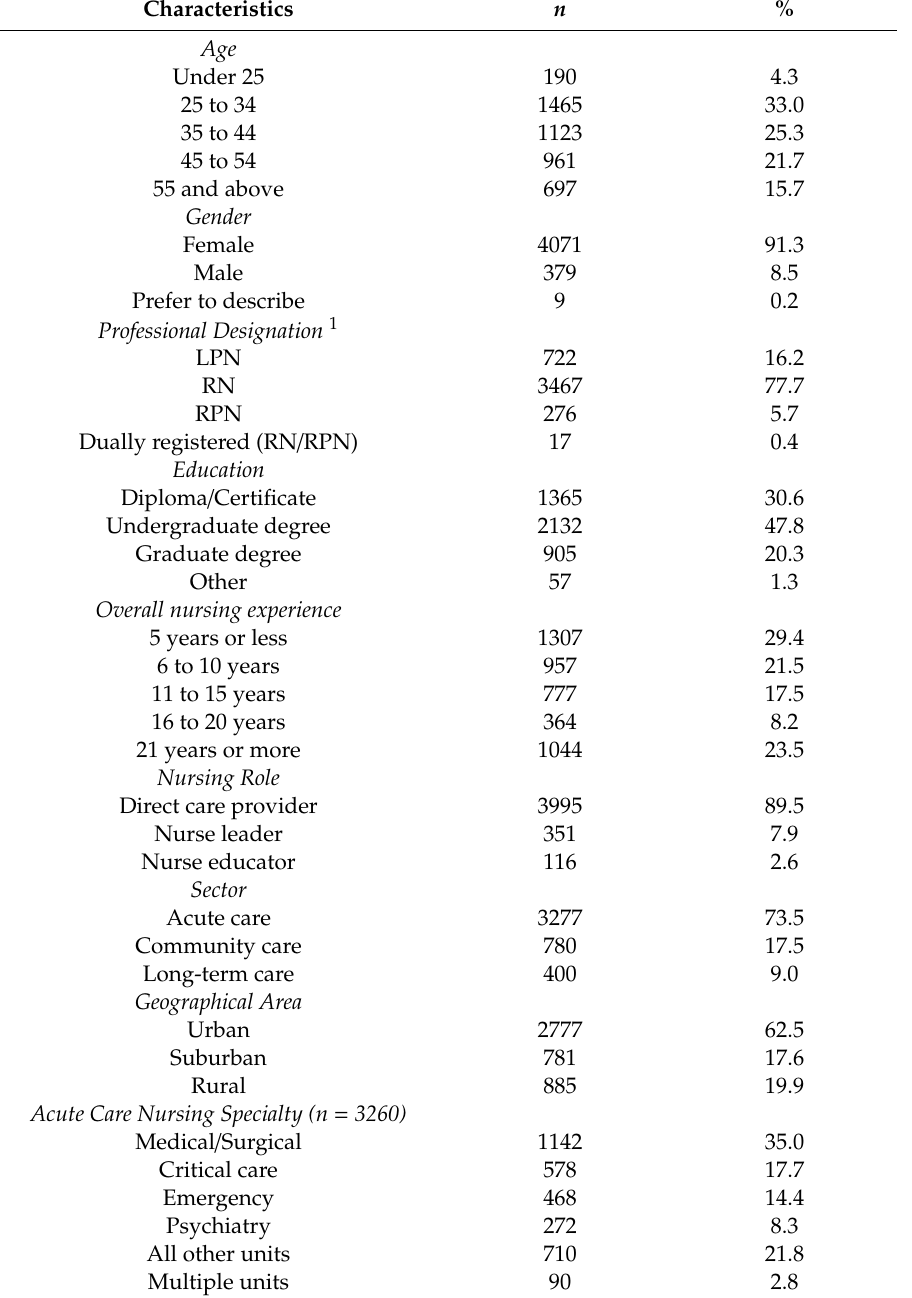
Table 1. Demographic and workplace characteristics ( n =